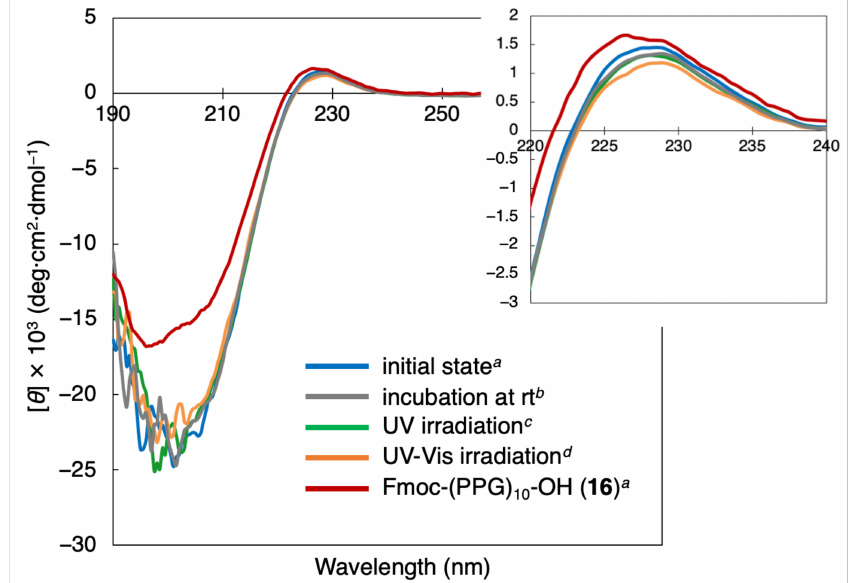
Figure 4. Changes in the CD spectra of Azo-(PPG) 10 upon irradiation with light. a Measurement was carried out before light irradiation. b Sample solution was incubated at room temperature in the dark, and then measured. c The sample solution was continuously irradiated with UV light (365 nm) for 1 h, and then measured. d The sample was alternatively irradiated with UV (365 nm, 5 min) and Vis (436 nm, 5 min) light six times, and then measured.